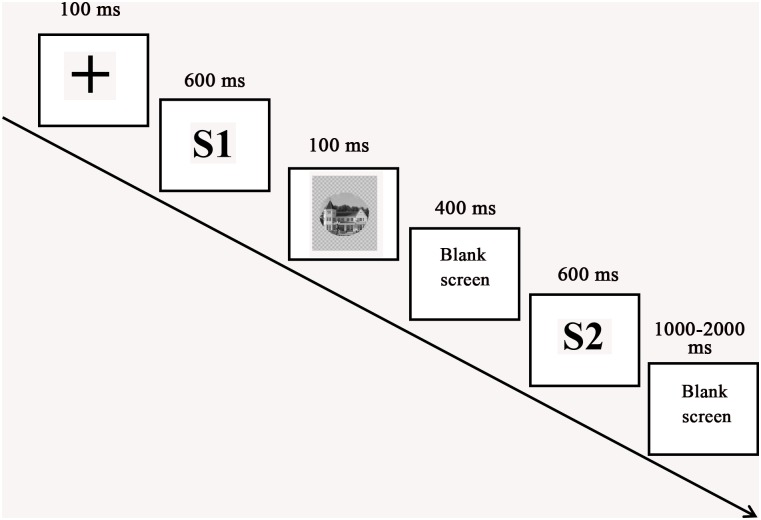
Schematic illustration of the experimental procedure.